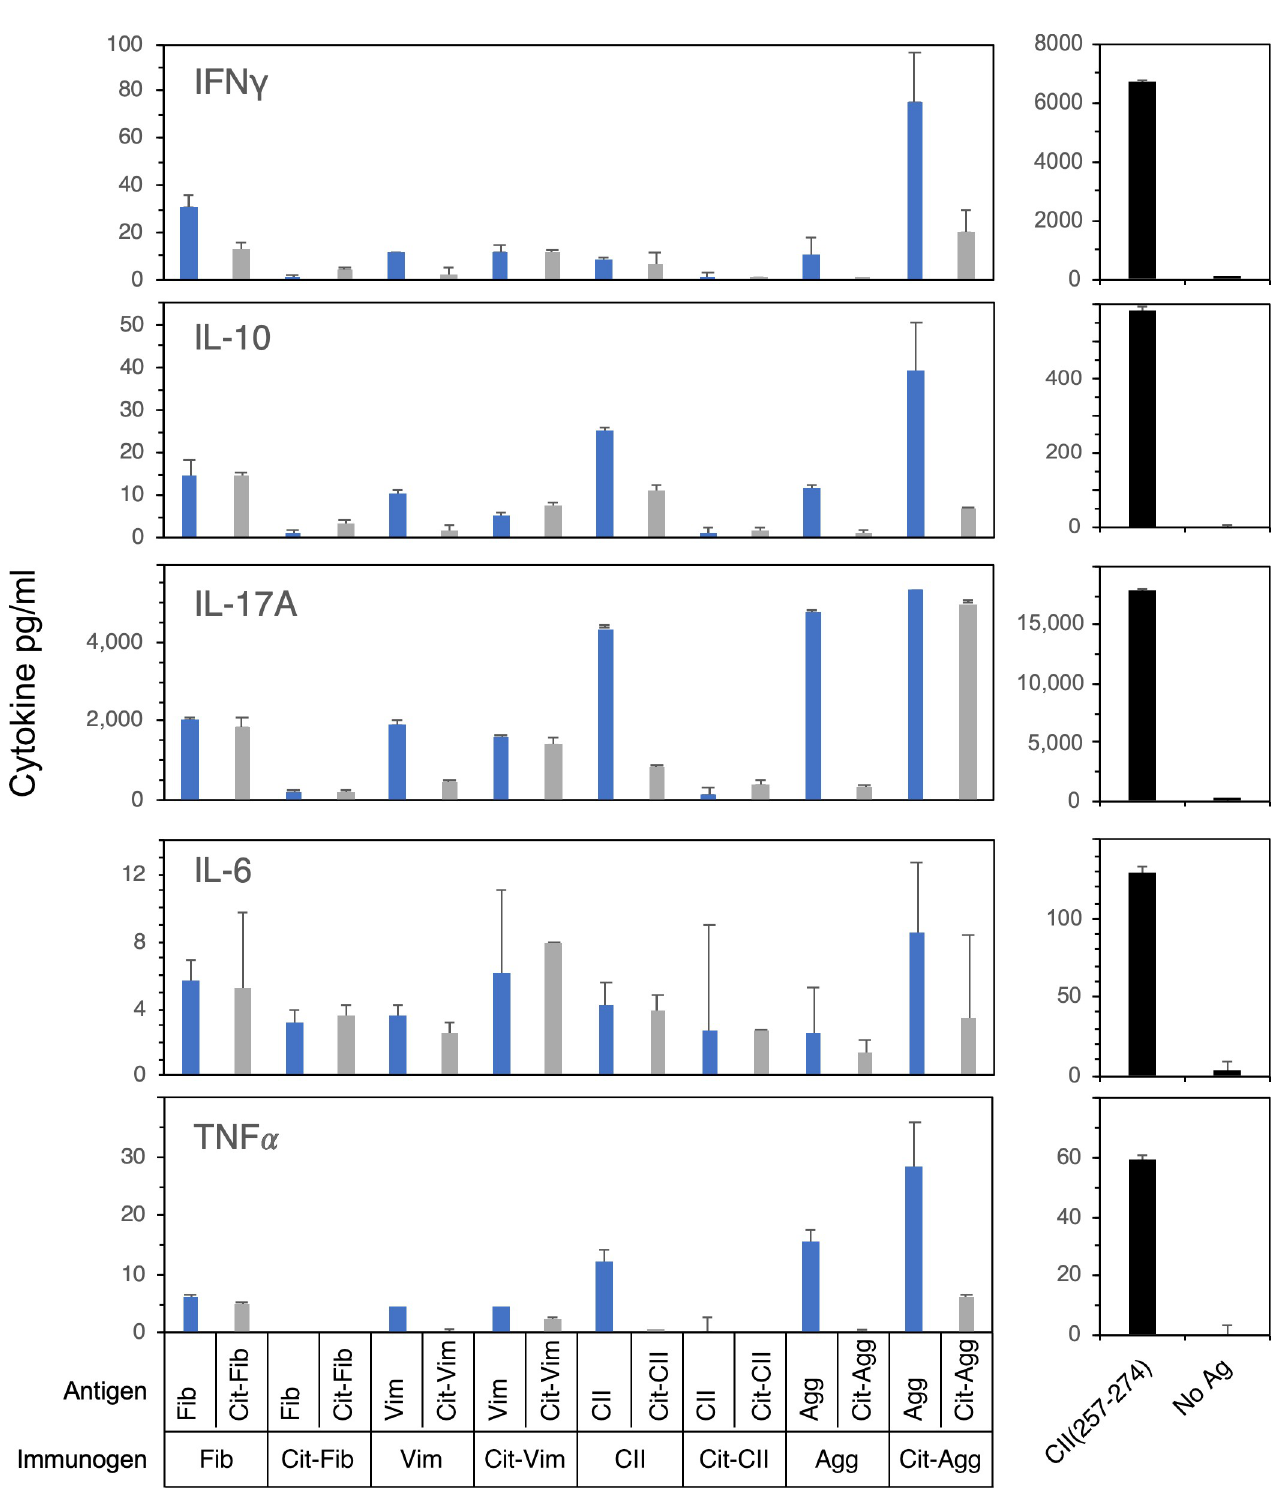
Fig 5. Cytokine production by T cells stimulated with WT or Cit-peptides. Supernatants from T cell proliferation assays in Fig 4 were collected 3 days after antigen stimulation and analyzed for the expression of proinflammatory cytokines. Cytokines produced were measured using a multiplexed bead assay and analyzed using a BioRad MagPix. Standard curves were used to calculate cytokine concentration. The cytokines produced by CII immunized T cells stimulated with the immunodominant epitope, CII(257–274), that drives autoimmune arthritis in the B6.DR1 model are shown for comparison (right panels). Data are representative of two independent experiments and based on duplicate